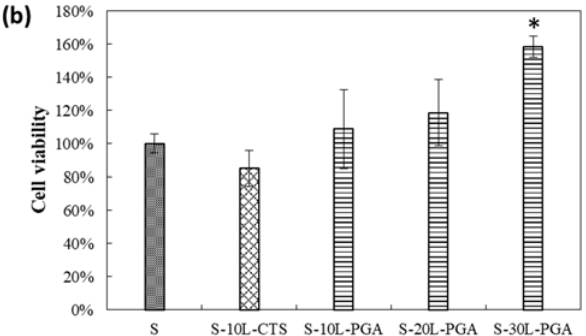
Figure 5. The cell viability of MG63 seeded on ( a ) Ti6Al4V substrate and ( b ) 316LSS substrate with different layers of PEMs coatings were measured using MTT assay. The bare metal substrate was used as the control. *: p < 0.05 compared to bare Ti6Al4V or 316LSS substrate.